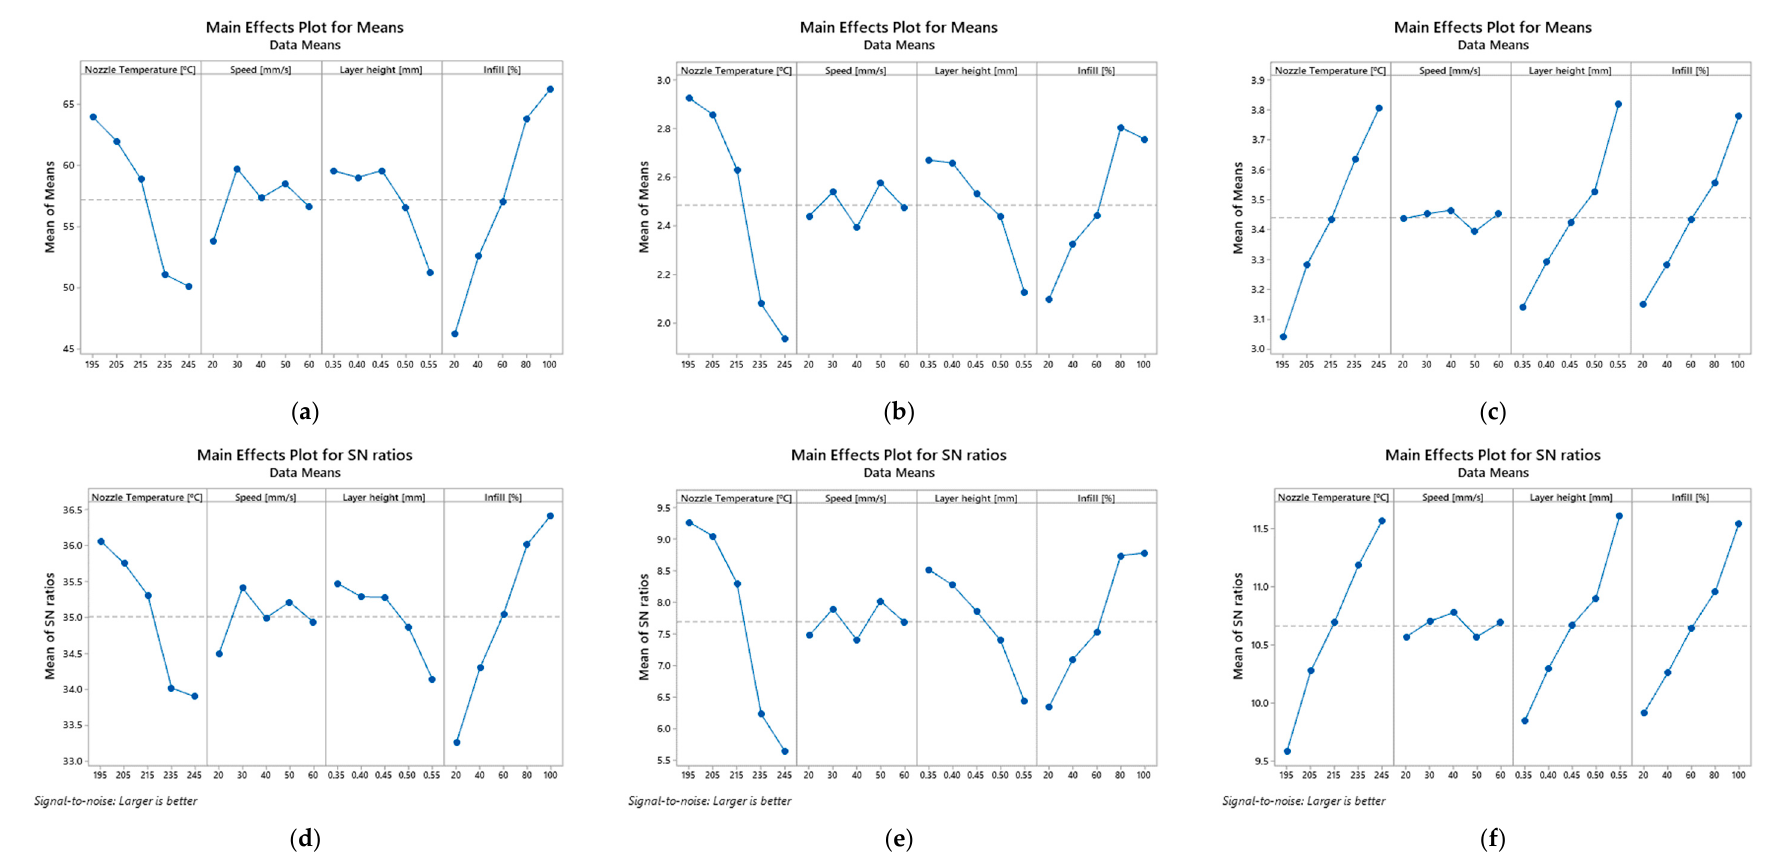
Figure 4. Main effect plot for means of: ( a ) bending stress, ( b ) bending modulus, ( c ) bending strain, and main effect plot for means of S/N ratios of: ( d ) fexural stress, ( e ) bending modulus, ( f ) bending strain for PETG+CF samples.